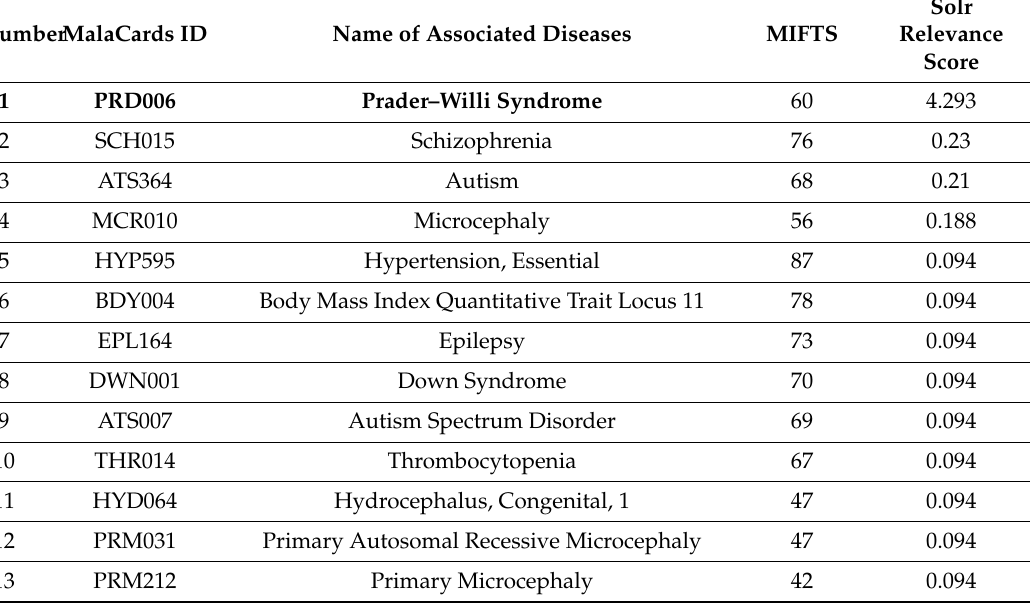
Table 13. Putative Associated Diseases for the TUBGCP5